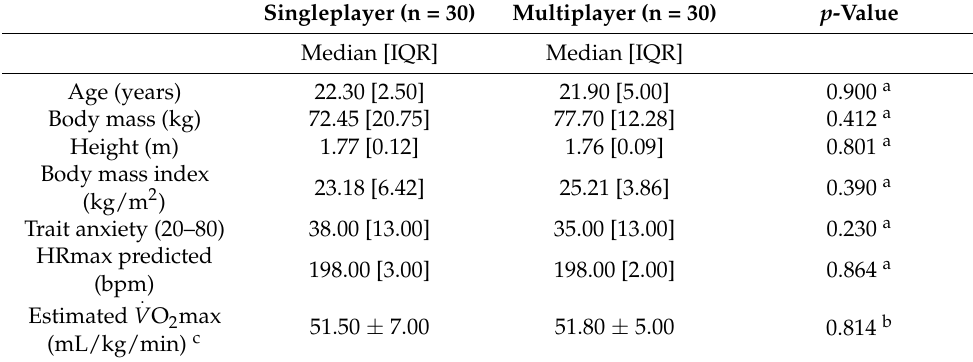
Table 1. Characteristics of the participants.